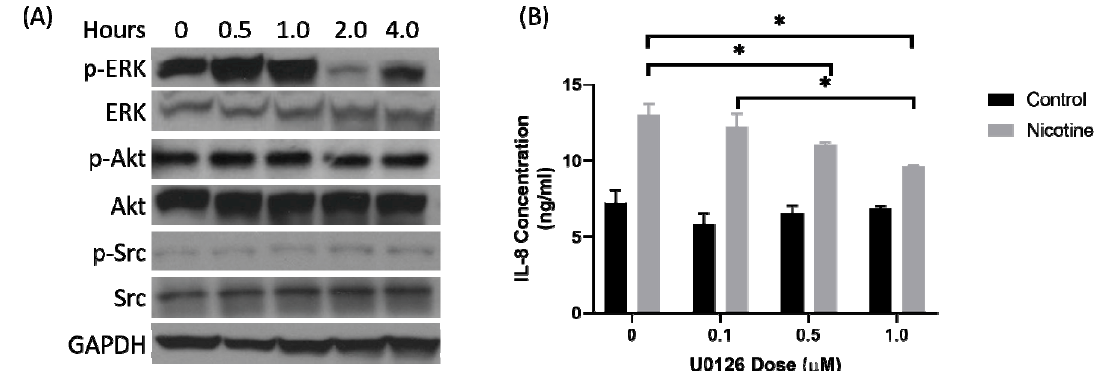
Figure 2. Secretion of IL-8 by the tumor-associated stroma was extracellular signal-regulated kinases (ERK) dependent. ( A ) Western blot analysis of TAS cells treated with nicotine (50 µ M) for the indicated time demonstrated phosphorylation, signified by “p-“, of ERK but no change in protein kinase B (Akt) or Proto-oncogene tyrosine-protein kinase Src (Src). ( B ) TAS cells were then pre-treated with an escalating dose of U0126, an inhibitor of MAPK / ERK kinase (MEK) that phosphorylates ERK, and then with nicotine or control 1 h later. MEK inhibition decreased IL-8 secretion in the nicotine-treated TAS cells. IL-8 secretion decreased with an increasing dose of U0126. The uncropped blots and molecular weight markers are shown in Figure S1 and Table S1.